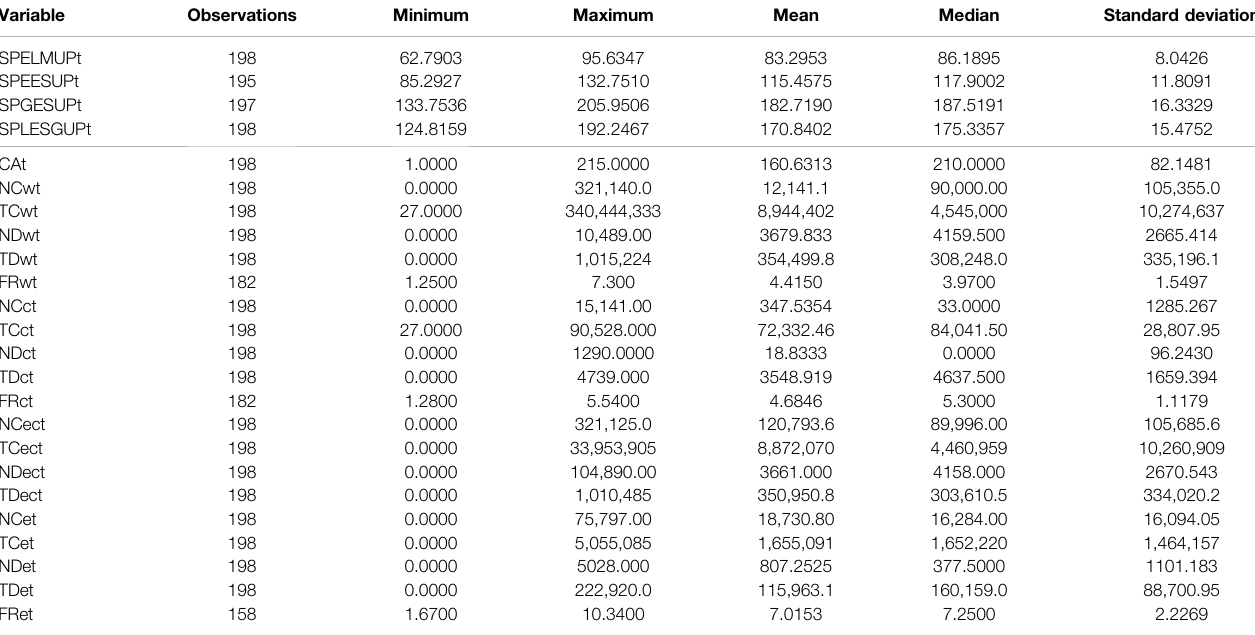
TABLE 4 | Summary of descriptive statistics of model